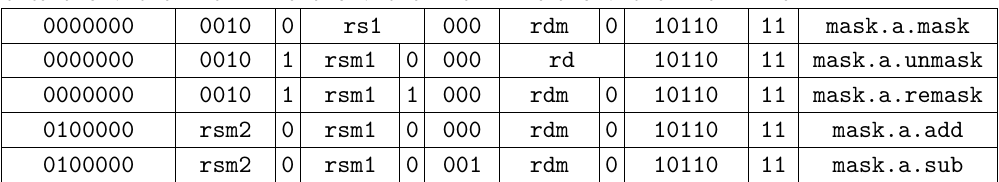
Table 8: Instruction encodings (A-class: operations under arithmetic masking).